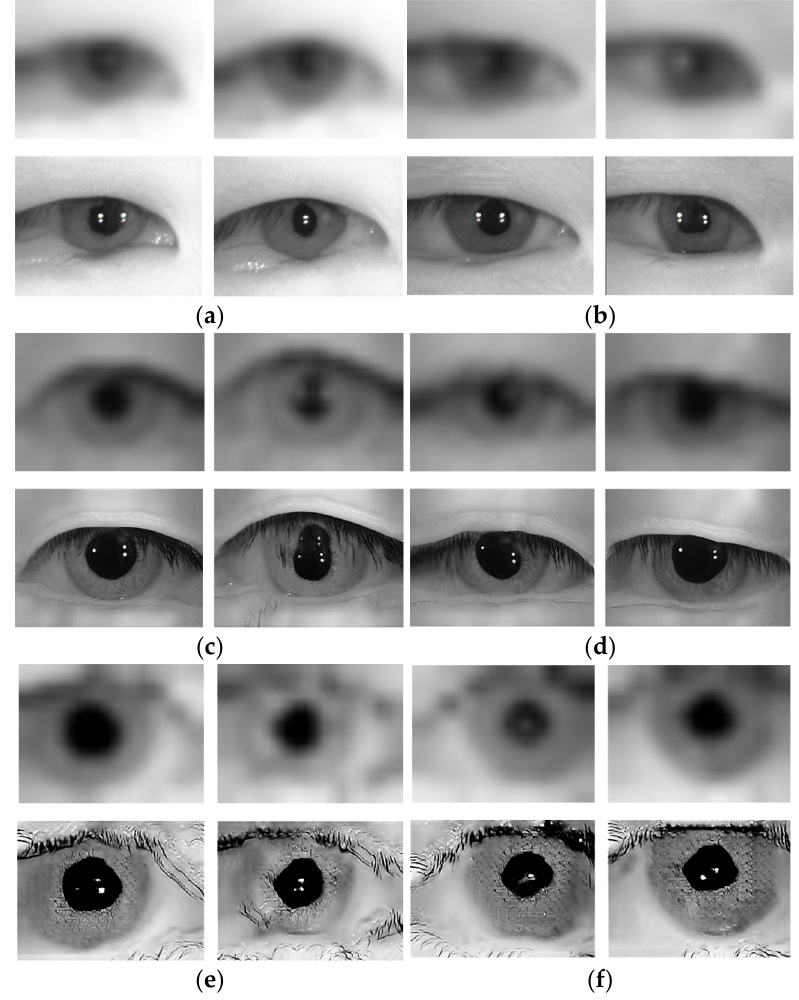
Figure 8. Example of recognition error cases by the proposed method. ( a , b ) CASIA-Iris-Distance database. ( c , d ) CASIA-Iris-Lamp database. ( e , f ) IIT Delhi iris database. ( a , c , e ) show false rejection cases. ( b , d , f ) show false acceptance cases. The left-hand and right-hand side images in ( a – f ) show registered images and recognition images, respectively. 1st and 2nd row images in ( a – f ) show low-resolution images and high-resolution images restored by OSRCycleGAN, respectively.